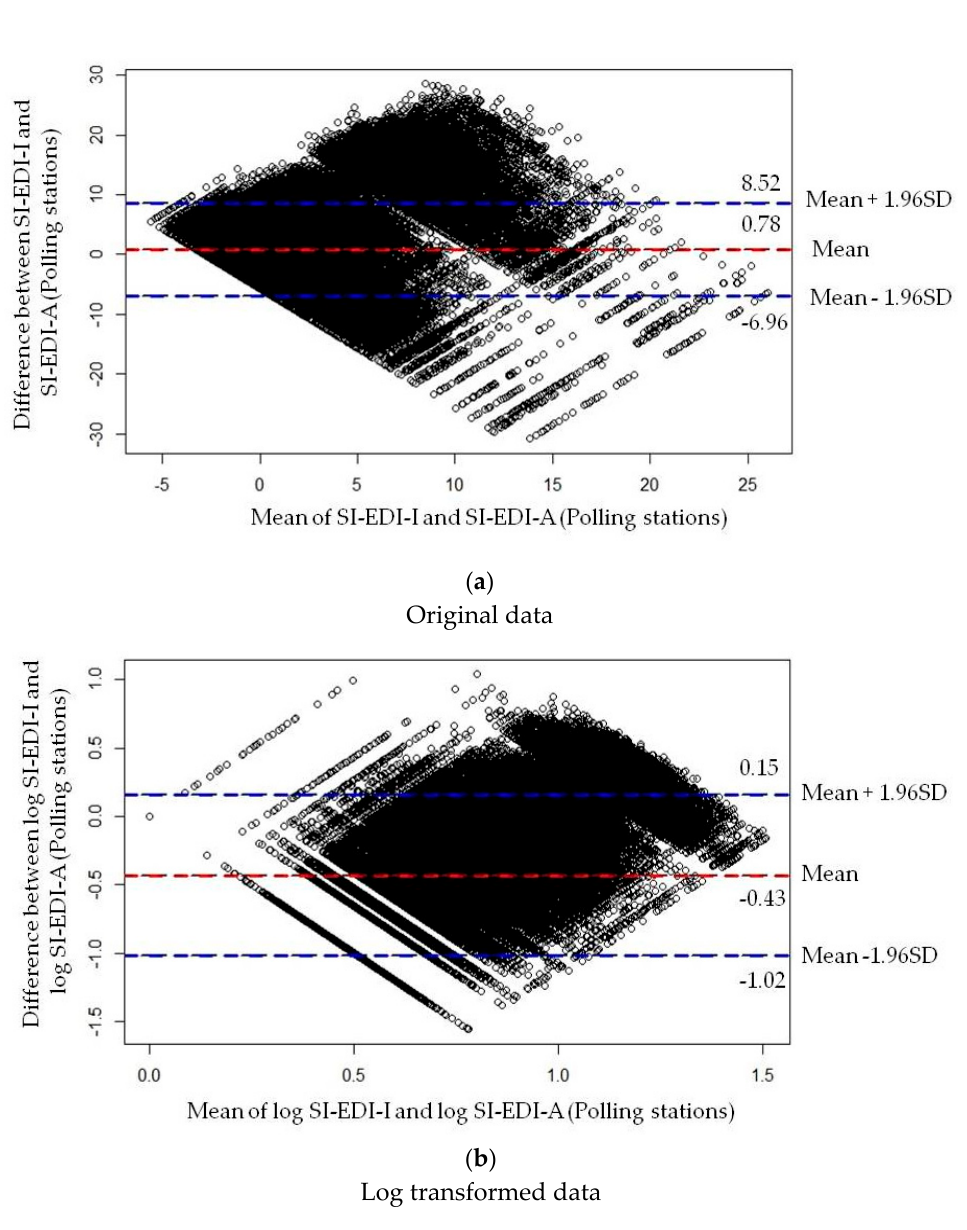
Figure 2. Bland–Altman plot: (a) Bland–Altman plot of original data; (b) Bland–Altman plot of logarithmic transformation of the data.